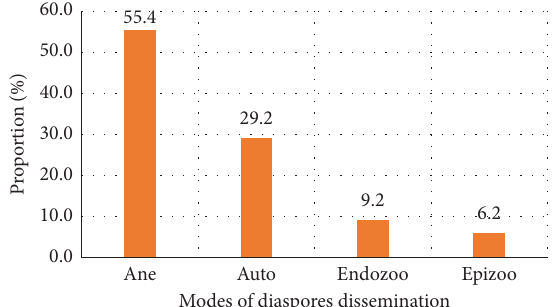
Figure 11: Proportion of diferent modes of diaspores dissemi- nation: (Ane) Anemochory, (Auto) Autochory, (Endozoo) Endozoochory, and (Epizoo) Epizoochory.